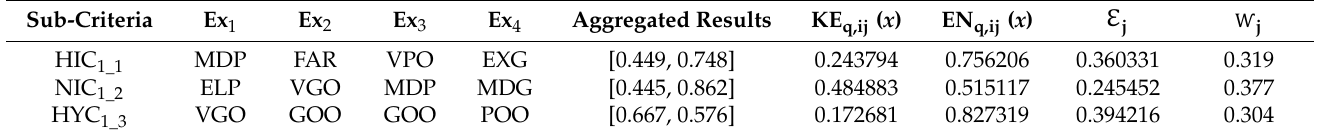
Table 6. Verbal evaluations of the protected system’s criteria and aggregated main criteria weights.